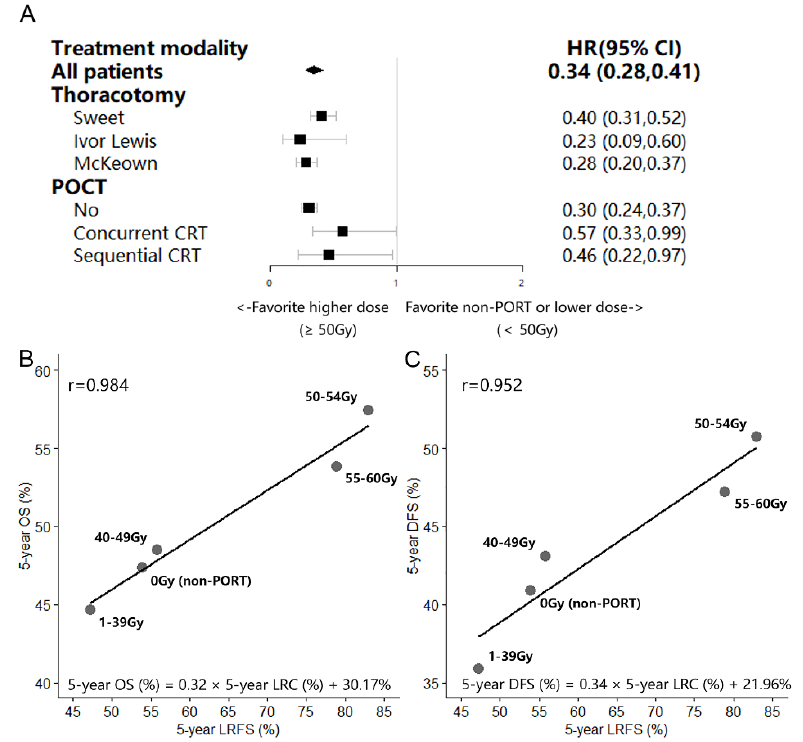
Figure 3. Stratified comparison of LRFS between patients treated with adjuvant radiation dose <50 Gy and ≥ 50 Gy ( A ) and linear regression analysis of LRFS and OS, DFS according to the adjuvant radiation dose ( B , C ) for 2765 patients with T1-2N1-3 or T3-4N0–3 lesions and available for the analysis of the effect of aRTD.